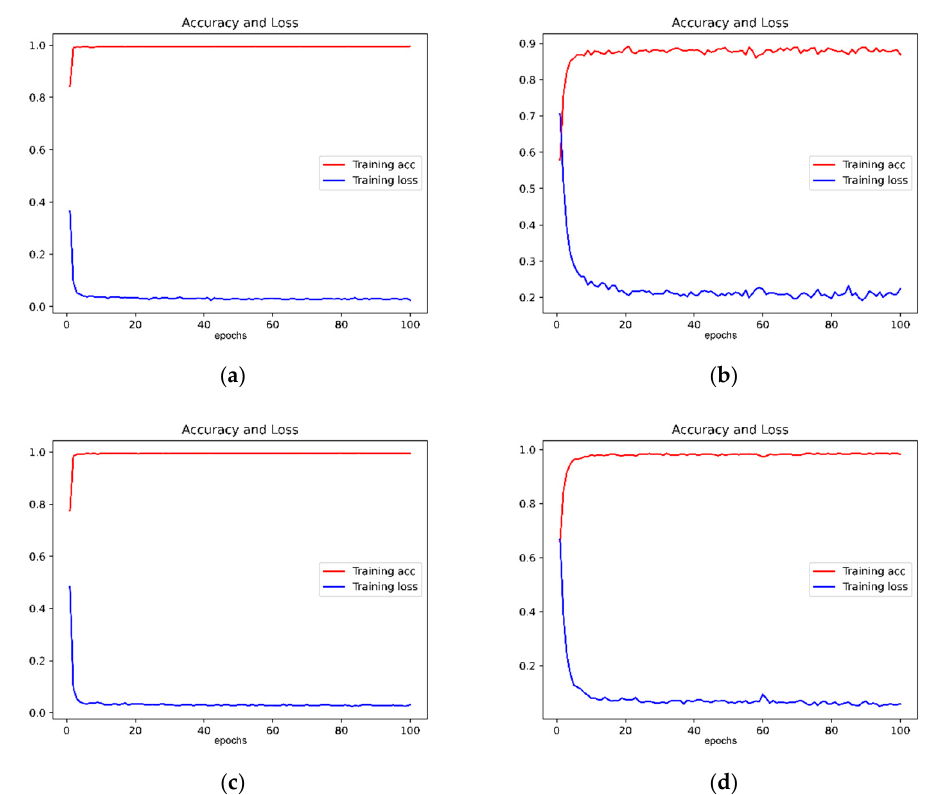
Figure 8. This figure is learning curves of our model at different magnification images: ( a ) Training progress of the proposed model on 40× magnification images; ( b ) Training progress of the proposed model on 100× magnification images; ( c ) Training progress of the proposed model on 200× magnifi- cation images; ( d ) Training progress of the proposed model on 400× magnification images.